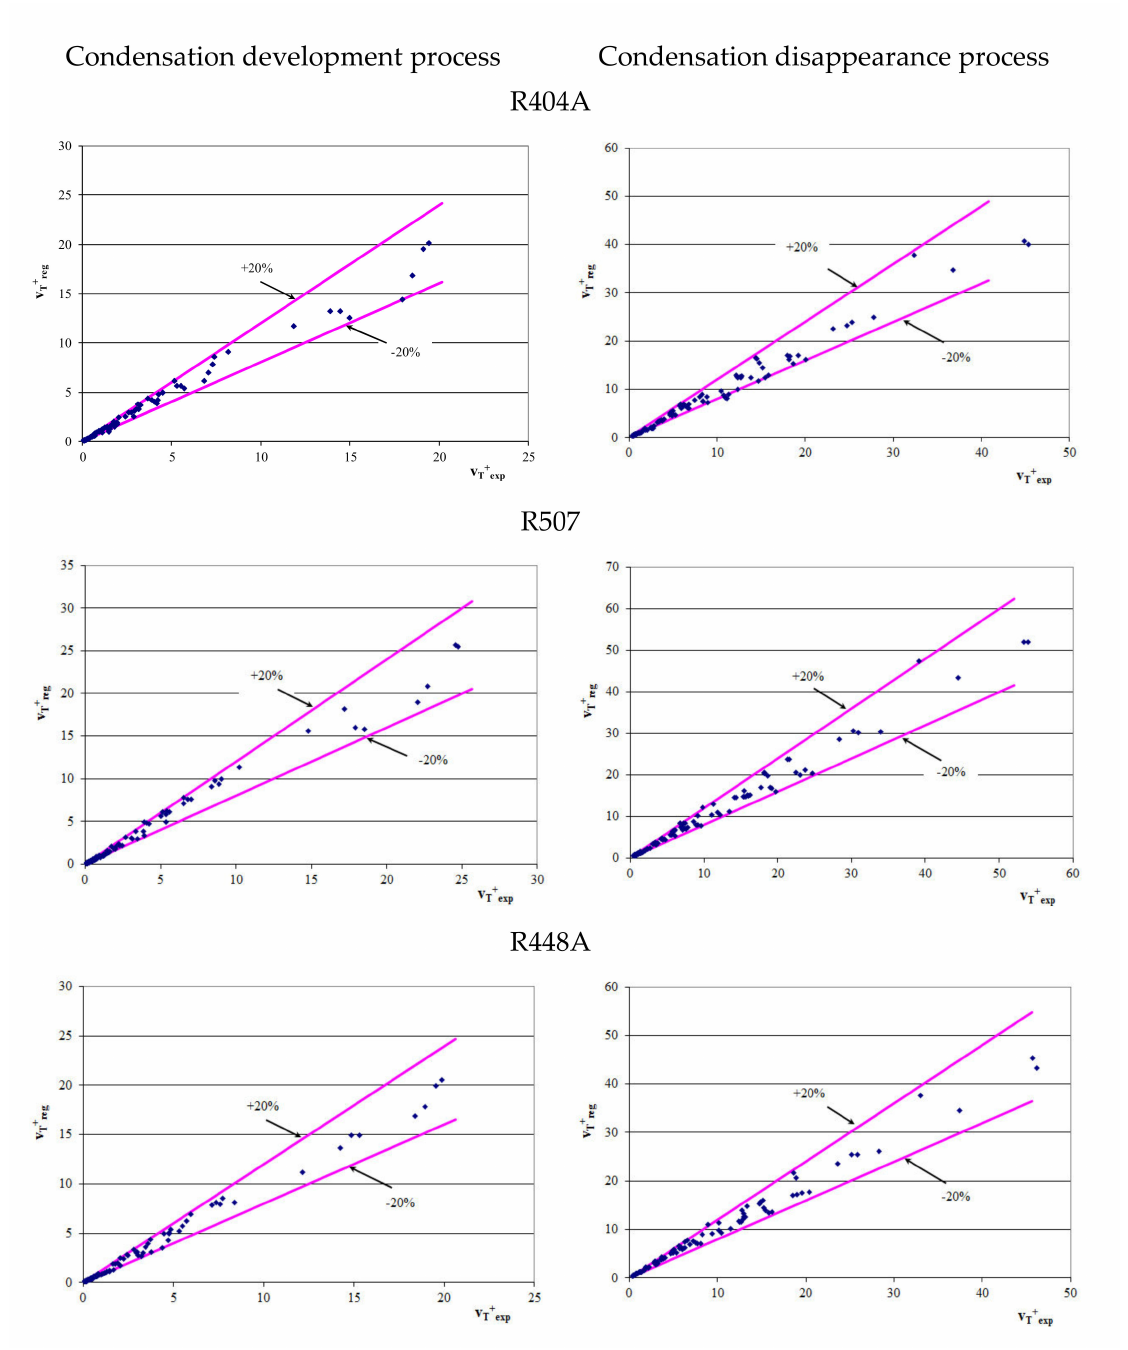
Figure 8. Scope of the compliance of the calculated and experimental results for the σ 2 variance and r-Pearson significance coefficients of the investigated R404A, R507 and R448A refrigerants for the values of the unit temperature instabilities, v + Treg